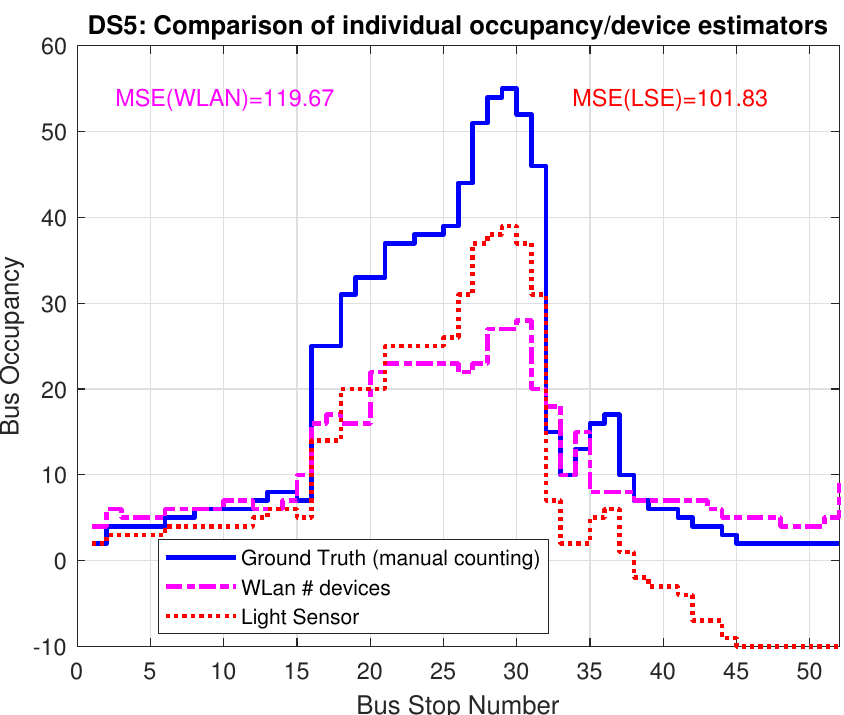
Figure 11. Bus occupancy (LSE) and number of detected devices (WLAN) for trace DS5 WITHOUT inclusion of λ and ω from the fusion approach. DS5: Comparison of estimators obtained by fusion